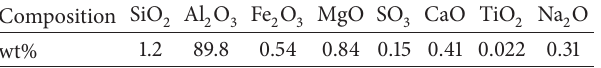
Table 1: Chemical composition of raw aluminium dross. Table 2: Effect of time on the surface area of aluminium dross at temperature of 25 ∘ C and concentration of NaOH at 1%.